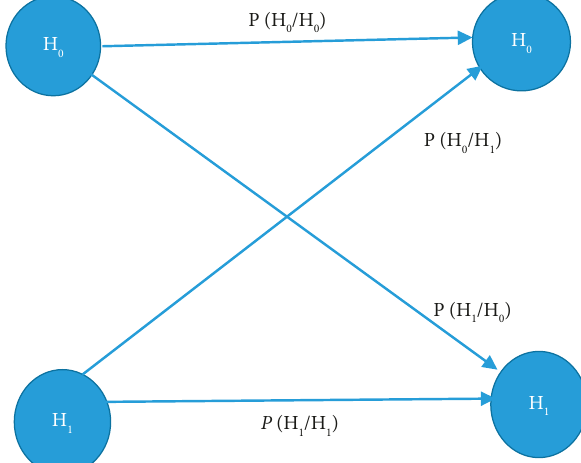
Figure 2: Hypothesis testing and probable outcomes, along with their